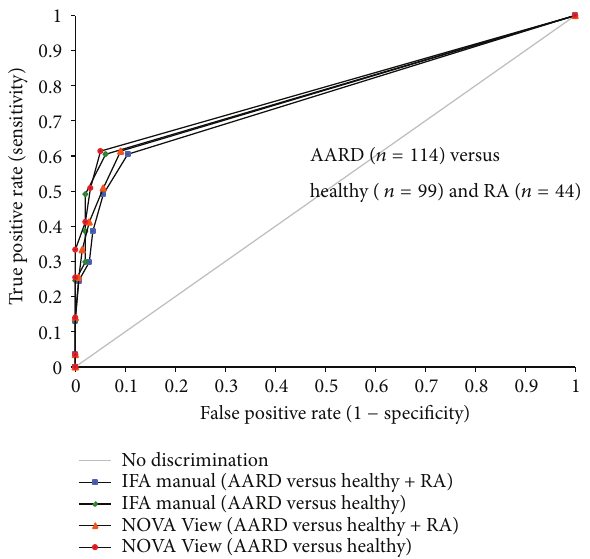
Figure 4: Antinuclear antibody titer and prevalence among ANA associated rheumatic diseases (AARD, 𝑛 = 114 ), rheumatoid arthritis (RA, 𝑛 = 44 ), and healthy controls ( 𝑛 = 99 ). Results are based on NOVA View archived images (similar results were found using manual